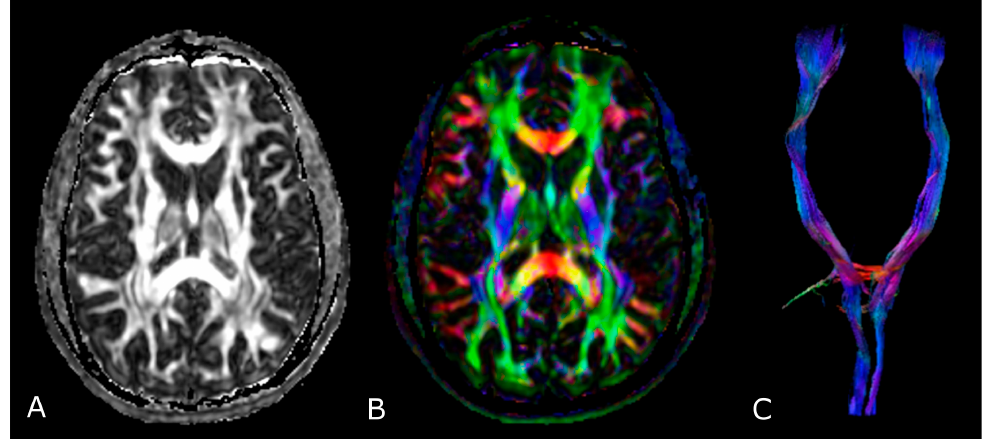
Figure 6. Diffusion Tensor Imaging: ( A ) normal FA map without any directional information; ( B ) Combined FA and directional map. Colors indicate directions as follows: red, left-right; green, anteroposterior; blue, superior-inferior. Brightness is proportional to FA; and ( C ) 3D visualization of normal corticospinal tracts.